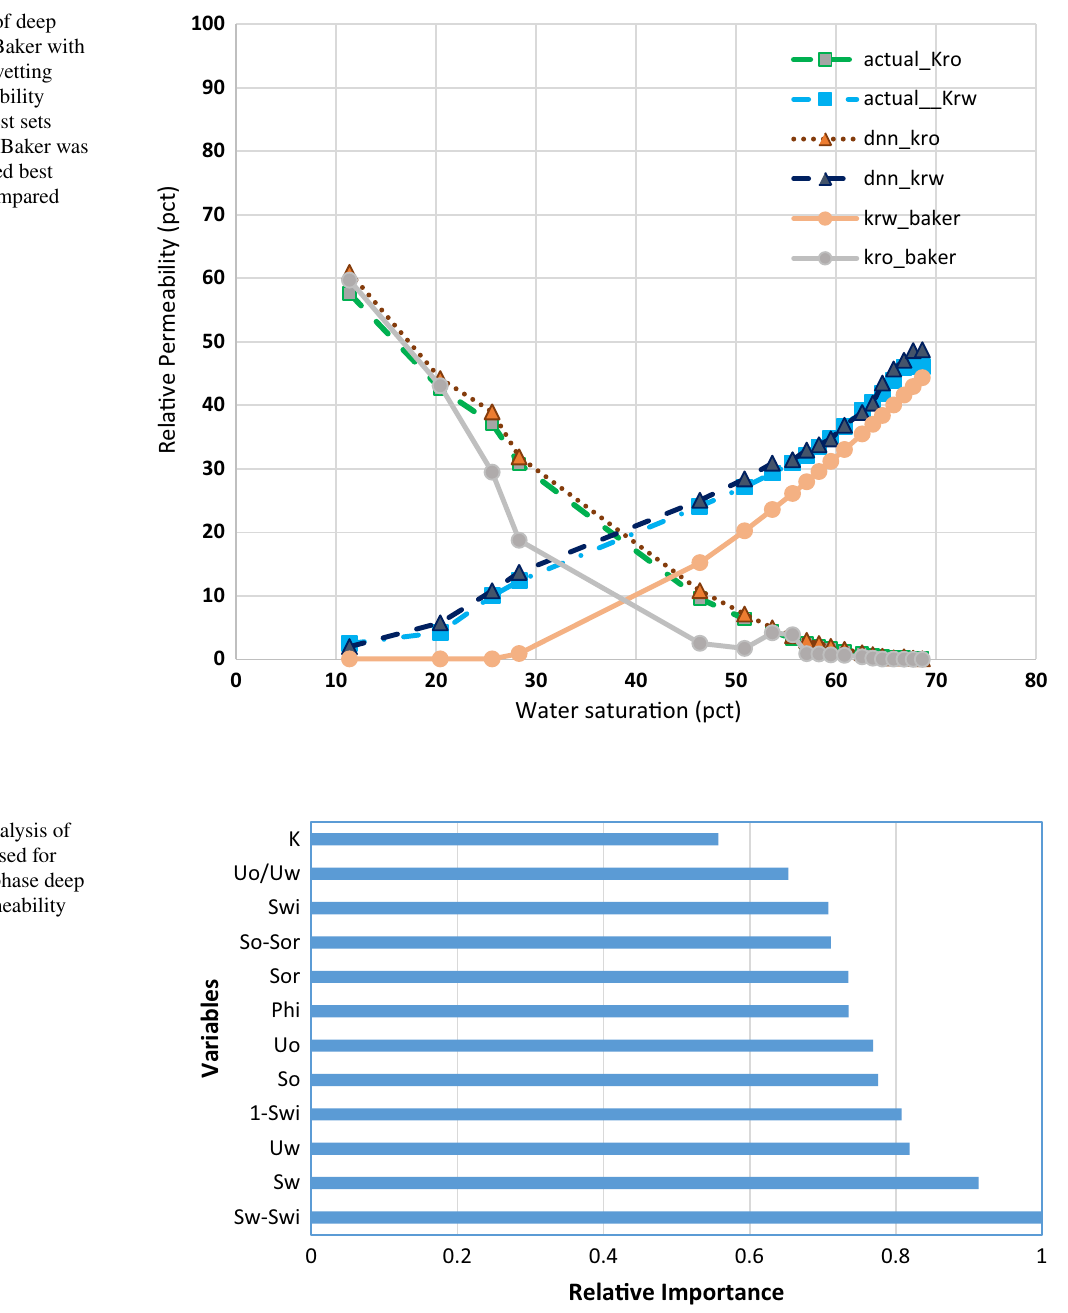
Fig. 12 Comparison of deep neural networks and Baker with the wetting and non-wetting phase relative permeability models with for the test sets (Stratjford reservoir). Baker was used since it performed best among the models compared